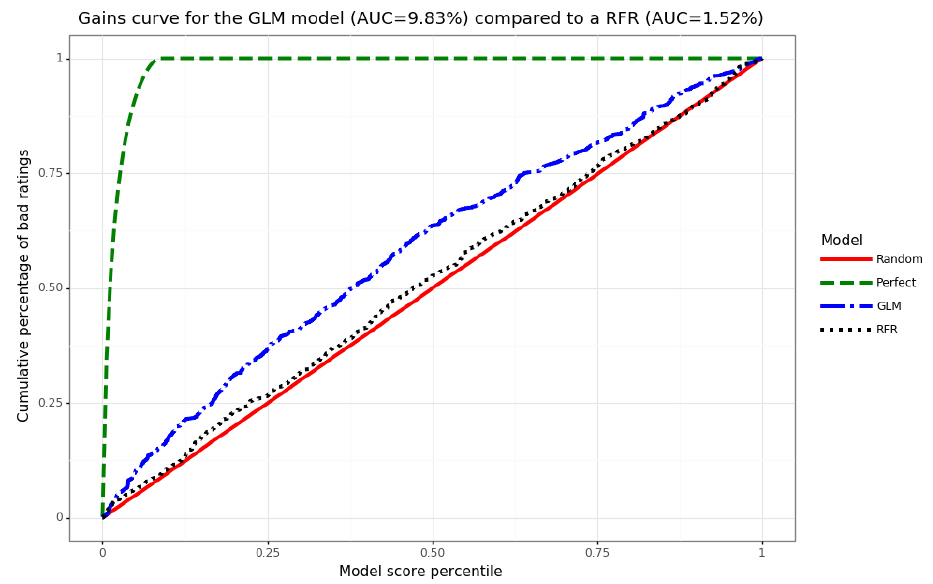
Figure 4. Gains curve for GLM predictions through a 10 fold cross-validation process, compared to a set of baselines: a random model, a perfect model with maximum gain and a